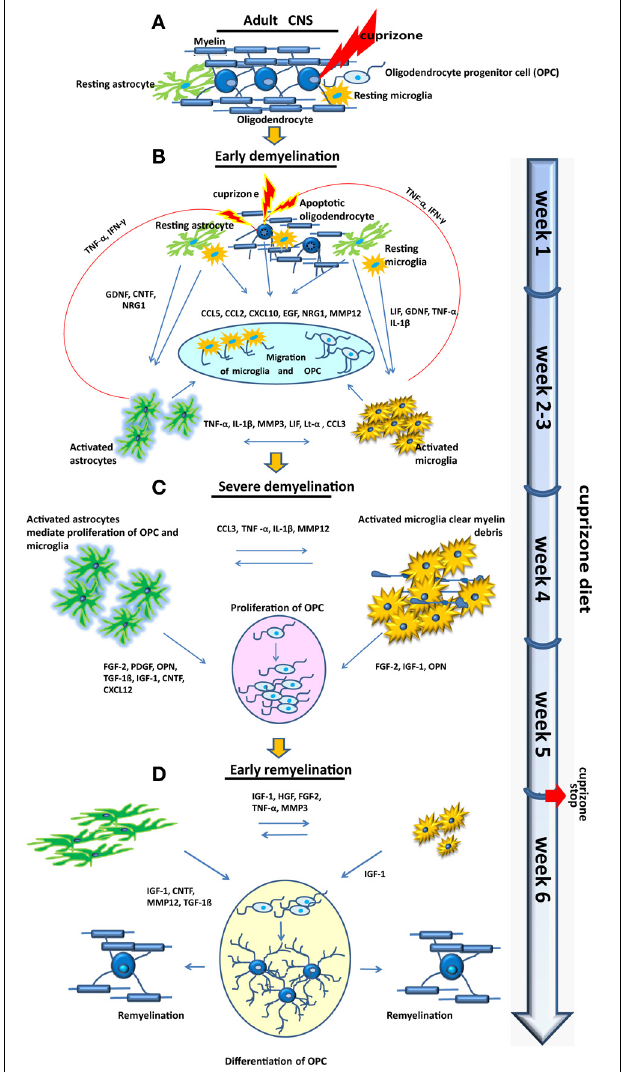
FIGURE 4 | Cellular and molecular response in the medial corpus callosum during cuprizone-induced de- and remyelination. (A) Distribution of glial cells under normal conditions. (B) Weeks 1–3, “early demyelination.” Mature oligodendrocytes begin to undergo apoptosis already during the first week of cuprizone feeding. Microglia are highly motile cells. They may detect apoptotic oligodendrocytes and initiate together with astrocytes numerous inflammatory and probably also reparative processes. Various chemokines, cytokines, and growth factors, promoting attraction and activation of microglia and astrocytes but also migration of OPC are produced during the first week of cuprizone treatment. In the next 2 weeks of the “early demyelination” period inflammatory cytokines are already slightly up-regulated and maintain the inflammatory cycle by further promoting activation and proliferation of astrocytes and microglia but probably harming oligodendrocytes as well. Oligodendrocytes are almost completely depleted at week 3 of cuprizone treatment. (C) Weeks 3.5–5, “severe demyelination.” Activated microglia begin to clear myelin debris. Several MMP, chemokines, cytokines, and growth factors produced by activated astrocytes and microglia are supporting phagocytosis and promoting proliferation of OPC. At week 5 nearly all axons in the medial corpus callosum are demyelinated. (D) Weeks 5–6 “early remyelination.” In this week the amount of activated microglia begins to decline. Astrocytes are still activated but change their morphology. OPC differentiate and begin to remyelinate nude